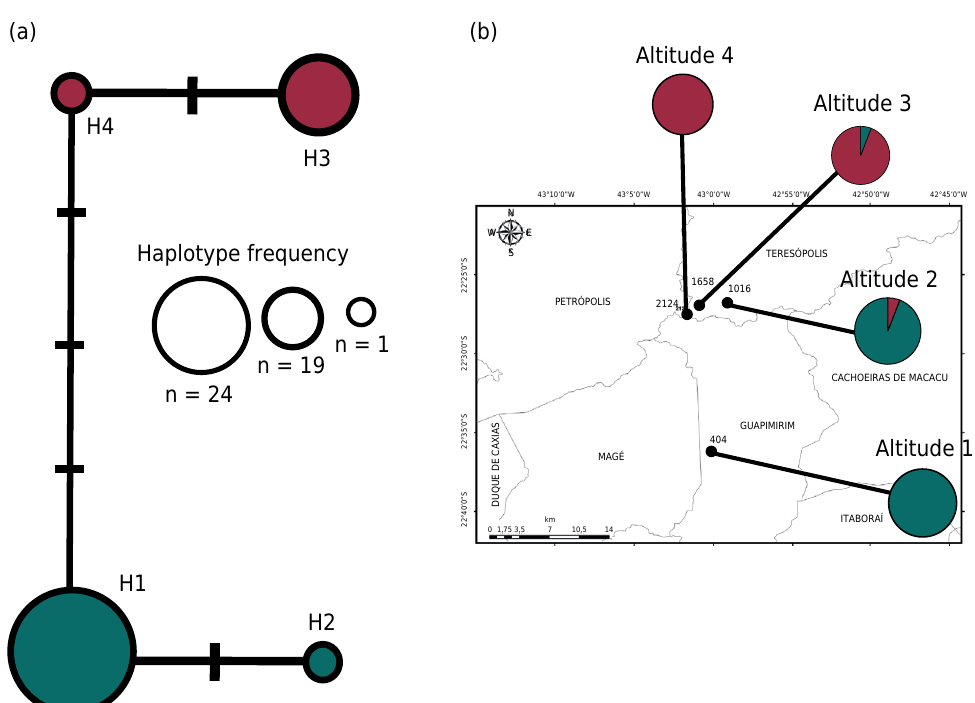
Figure 4. Median-joining network of the four haplotypes of Saitozyma podzolica . (a) The four haplotypes (H1, H2, H3, and H4) belong to two genealogical lineages, one depicted in green, and another one depicted in red. The circle sizes are proportional to the relative frequencies, major circle (n = 24), medium circle (n = 19), and small circles (n = 1). The number of mutation steps is indicated with small bars when more than one step occurs. (b) The distribution of the two genealogical lineages along the altitudinal gradient (altitudes 1, 2, 3, and 4).